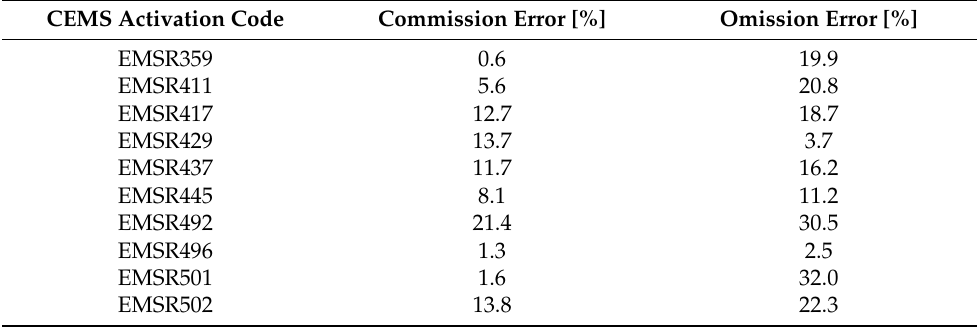
Table 6. Commission and omission errors for the class of permanent water.